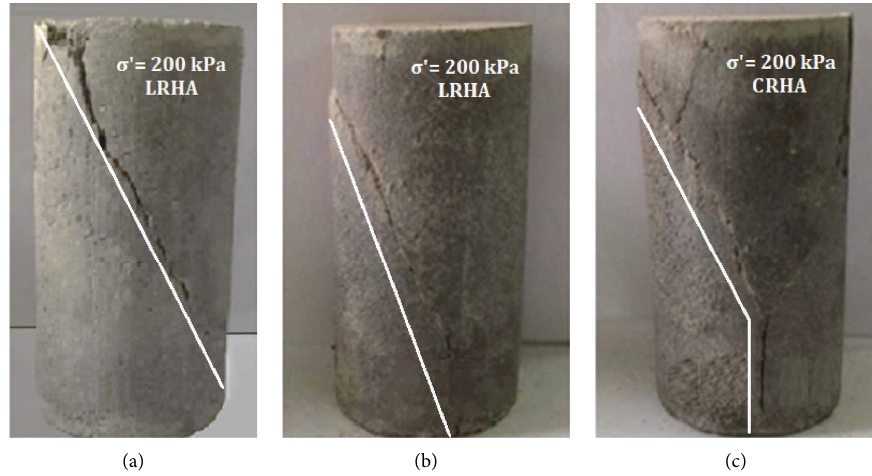
Figure 2: Comparison between CRHA and LRHA failure modes. (a) CRHA and (b and c) LRHA.